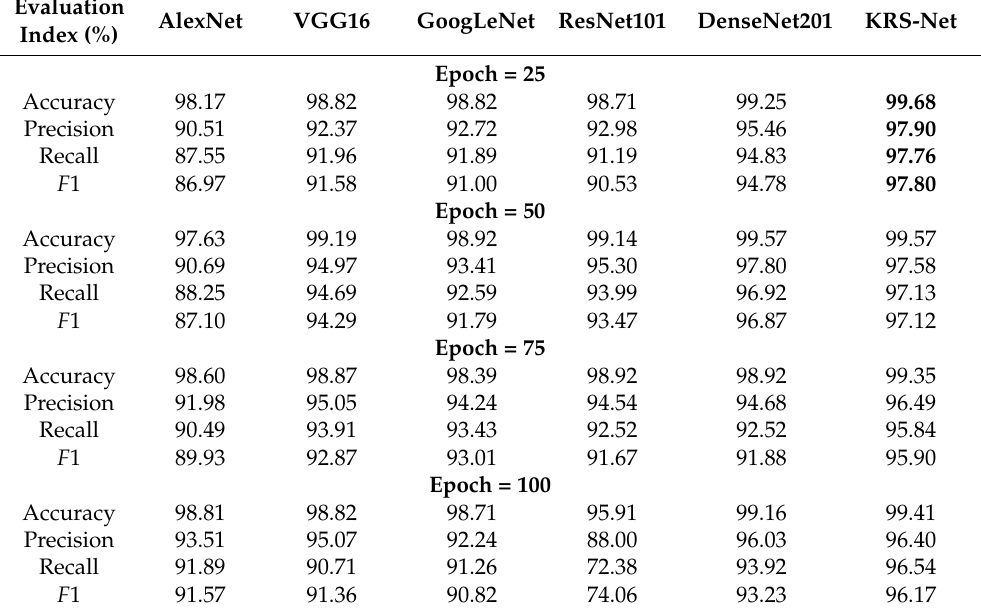
Table 3. Performance evaluation of